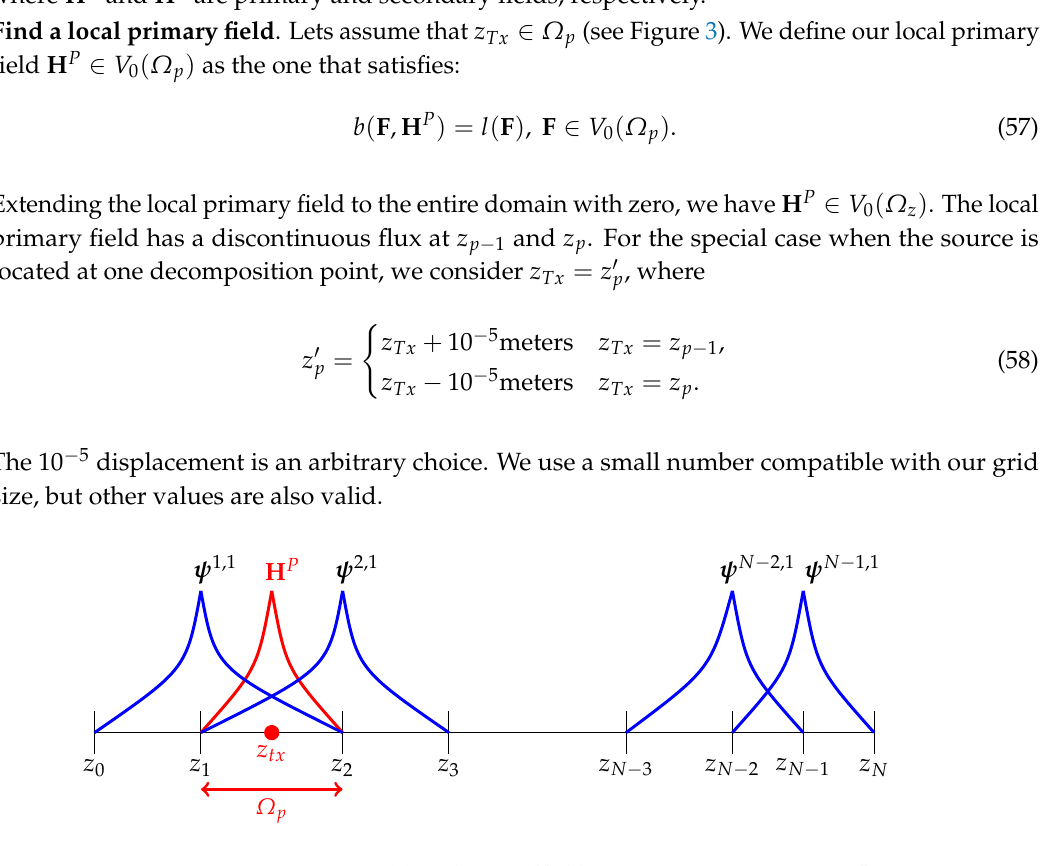
Figure 3. Multi-scale basis functions ψ 1,1 , ψ 2,1 , · · · , ψ N − 1,1 and local primary field H P . Ω p is the domain of the local primary